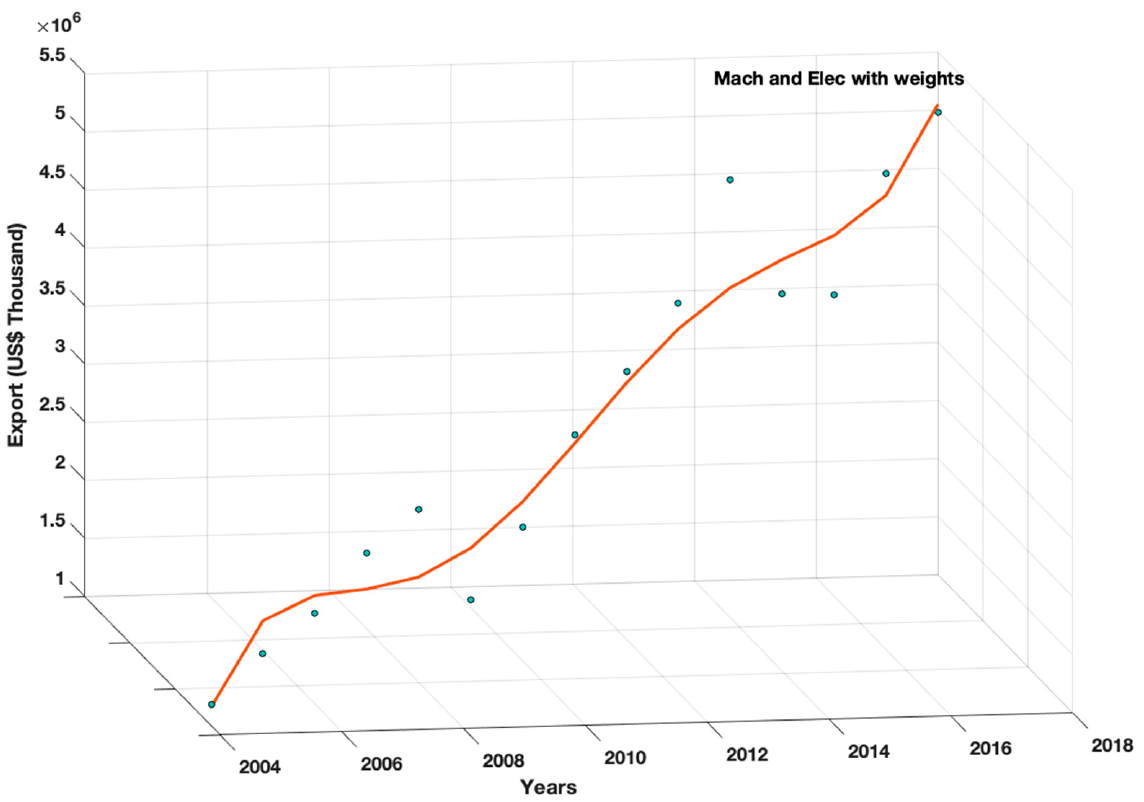
Figure 4. The degree 9 polynomial.